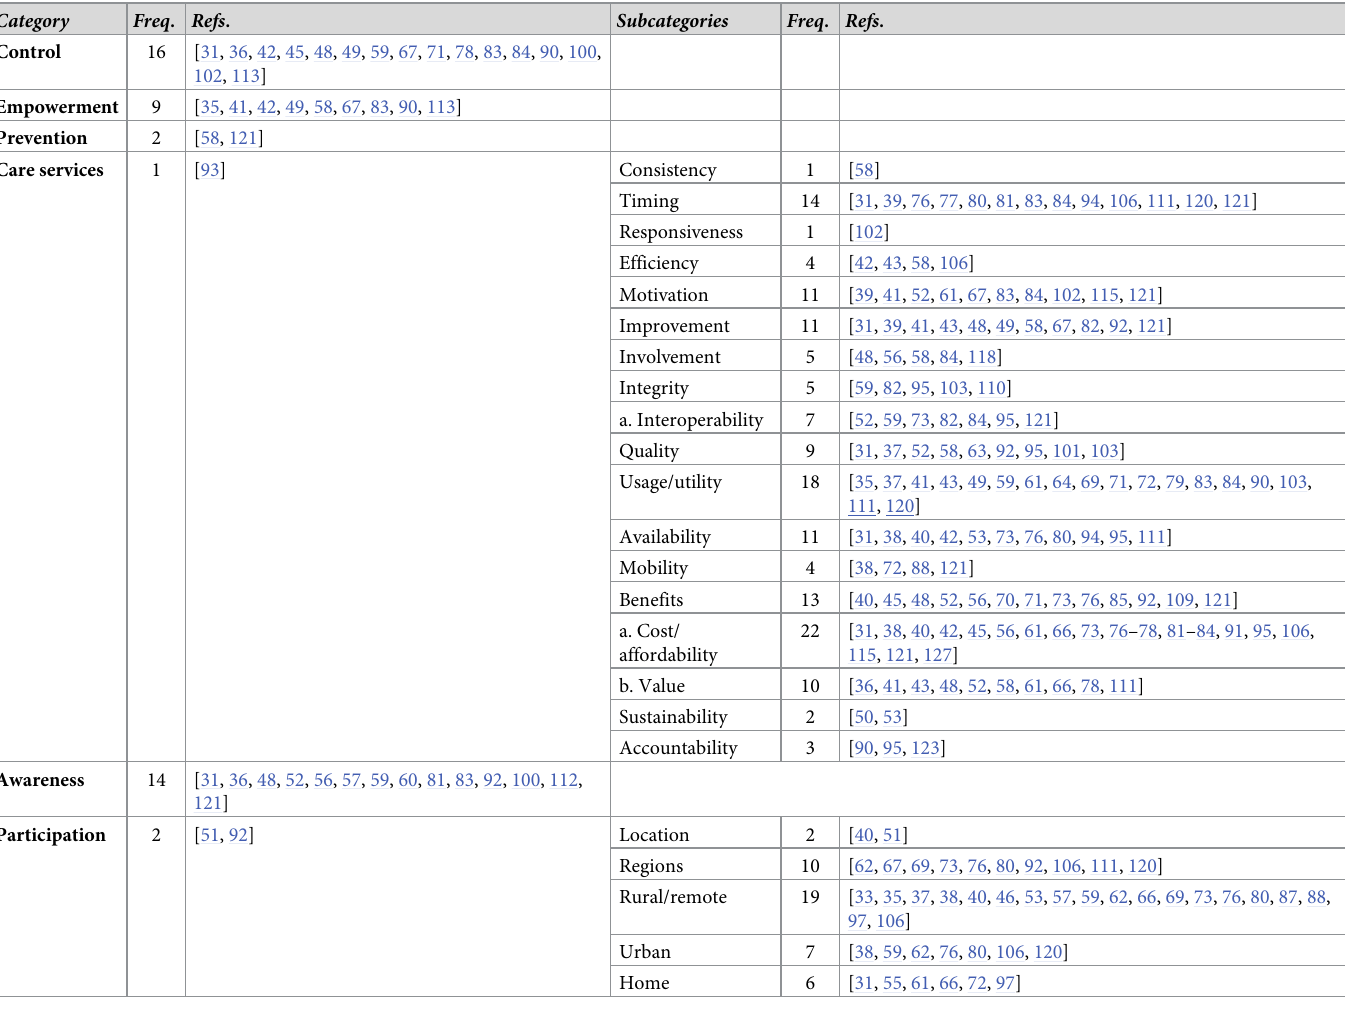
Table 8. Summary of findings in the reviewed literature: Needs, preferences and requirements. Category Freq . Refs